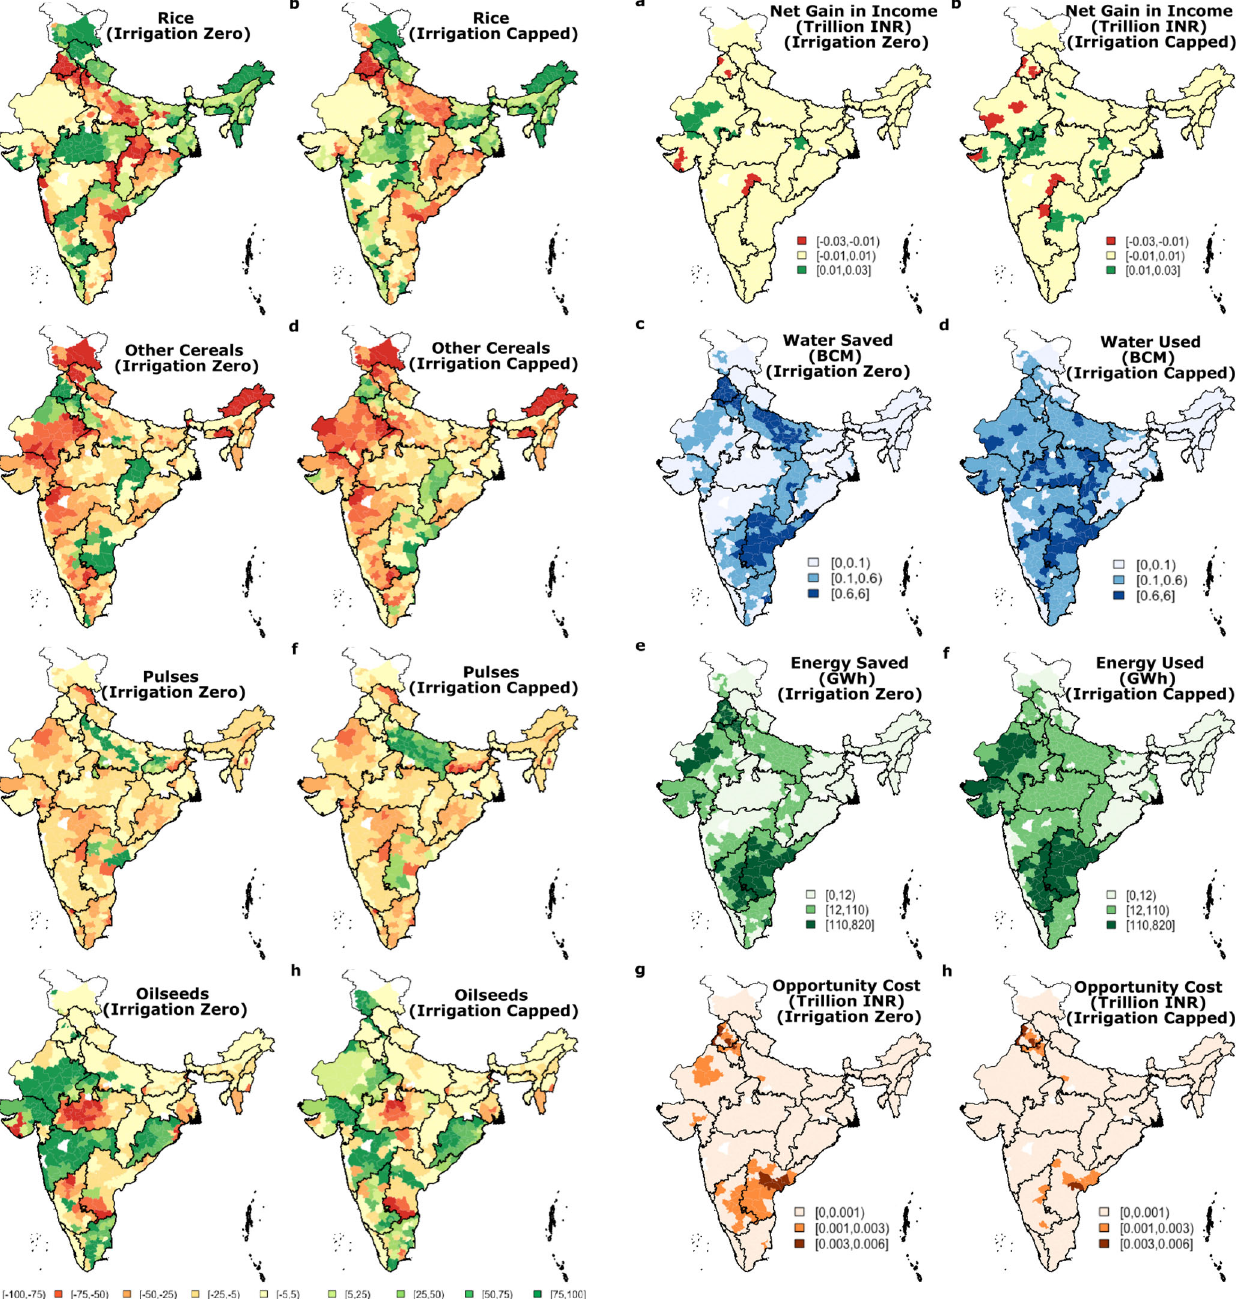
Fig. 4 Spatial distribution of net revenue, water and energy use, and energy opportunity cost. a , b Net gain in farm income under “ Irrigation Zero ” and “ Irrigation Capped ” scenarios. c , d Water saved/used under the “ Irrigation Zero ” and “ Irrigation Capped ” scenarios. e , f Energy saved/used under the “ Irrigation Zero ” and “ Irrigation Capped ” scenarios. g , h Opportunity cost under the “ Irrigation Zero ” and “ Irrigation Capped ”